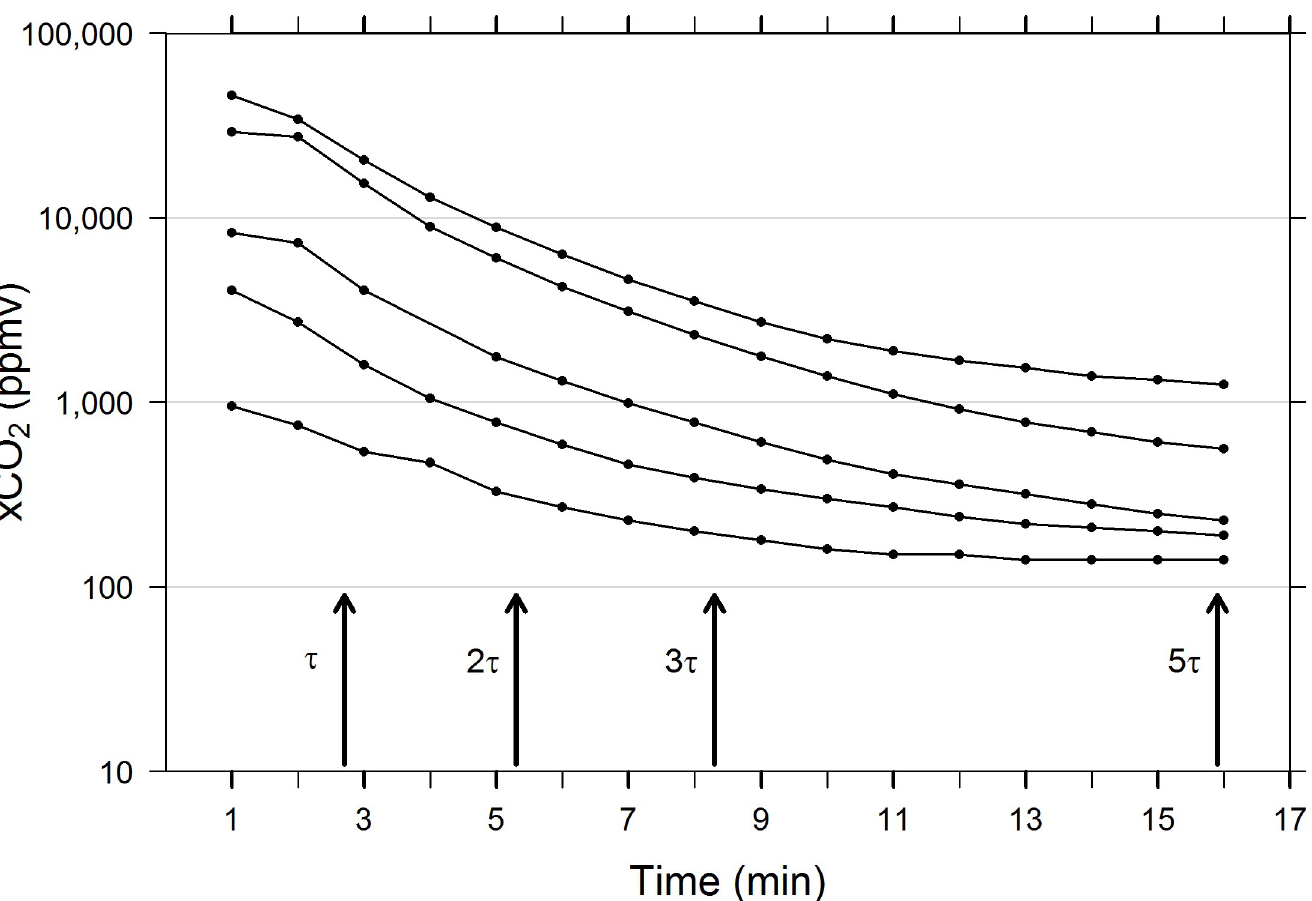
Fig 9. Results from five high to low concentration equilibration trials. Multiples of τ (mins) correspond to 36.8%, 13.5%, 5.0%, 0.7% of maximum values measured. Arrows indicate mean τ values for all five trials (see Table 1 for summary of mean and standard deviation values). Concentrations are plotted on a log scale to better visualize low and high ranges.